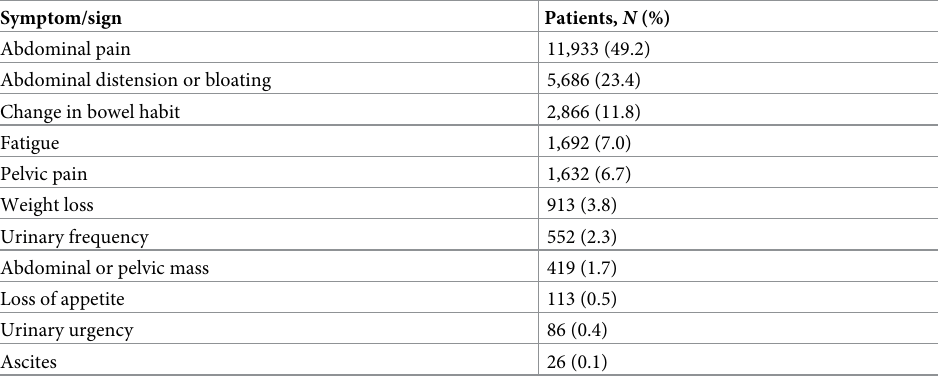
Table 2. Ovarian cancer symptoms and signs coded in the 30 days prior to CA125 testing.